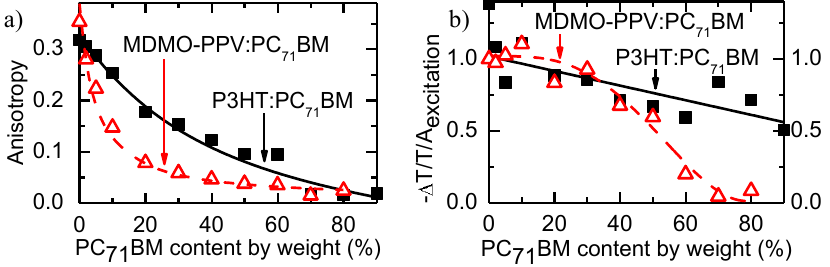
Fig. 2. Anisotropy at 0.5 ps delay (a) and maximal polaron generation efficiency (i.e. transmission changes normalized on the number of photons absorbed) – (b) as functions of fullerene